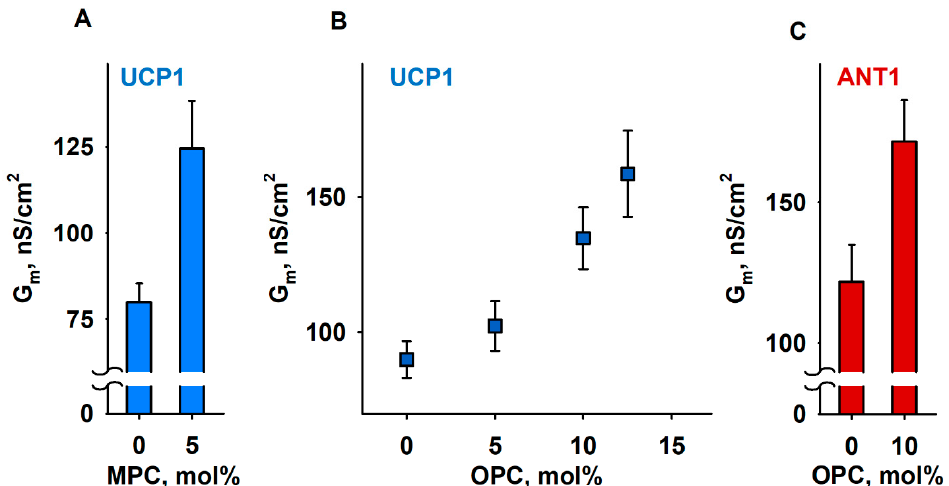
Figure 4. Lipid shape affects UCP1- and ANT1-mediated total membrane conductance ( G m ). ( A , B ) Dependence of G m measured in membranes reconstituted with recombinant UCP1 on the concentration of lysolipids MPC ( A ) and OPC ( B ). ( C ). Dependence of G m measured in membranes reconstituted with recombinant ANT1 on the concentration of OPC. The lipid composition in control experiments was DOPC:DOPE:CL (45:45:10). The specified lysolipid amount (mol%) was used instead of DOPC and DOPE. The concentrations of UCP1 and ANT1 were 4–5 µ g/(mg lipid). The concentrations of lipid and AA were 1.5 mg/mL and 15 mol%, respectively. The buffer solution contained 50 mM Na 2 SO 4 , 10 mM MES, 10 mM Tris, and 0.6 mM EGTA, at pH = 7.32 and T = 305 K. Data points represent means and standard deviation from 3–5 independent